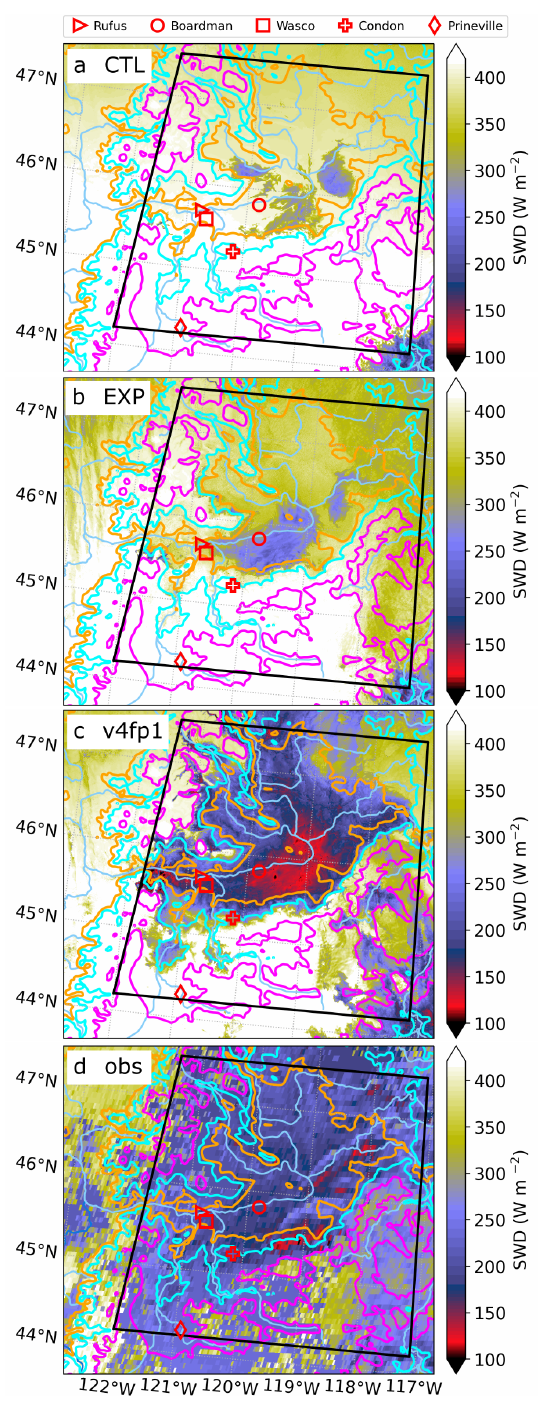
Figure 7. Spatial distribution of surface shortwave downward radia- tion flux (SWD) in d02 (a) CTL, (b) EXP, and (c) v4fp1, and (d) de- tected by satellite at 21:00UTC on 14 January. Terrain height con- tours are indicated by orange (500m), cyan (750m), and magenta (1250m) isolines, and rivers are shown in blue. The red markers indicate the locations of stations with radiation flux